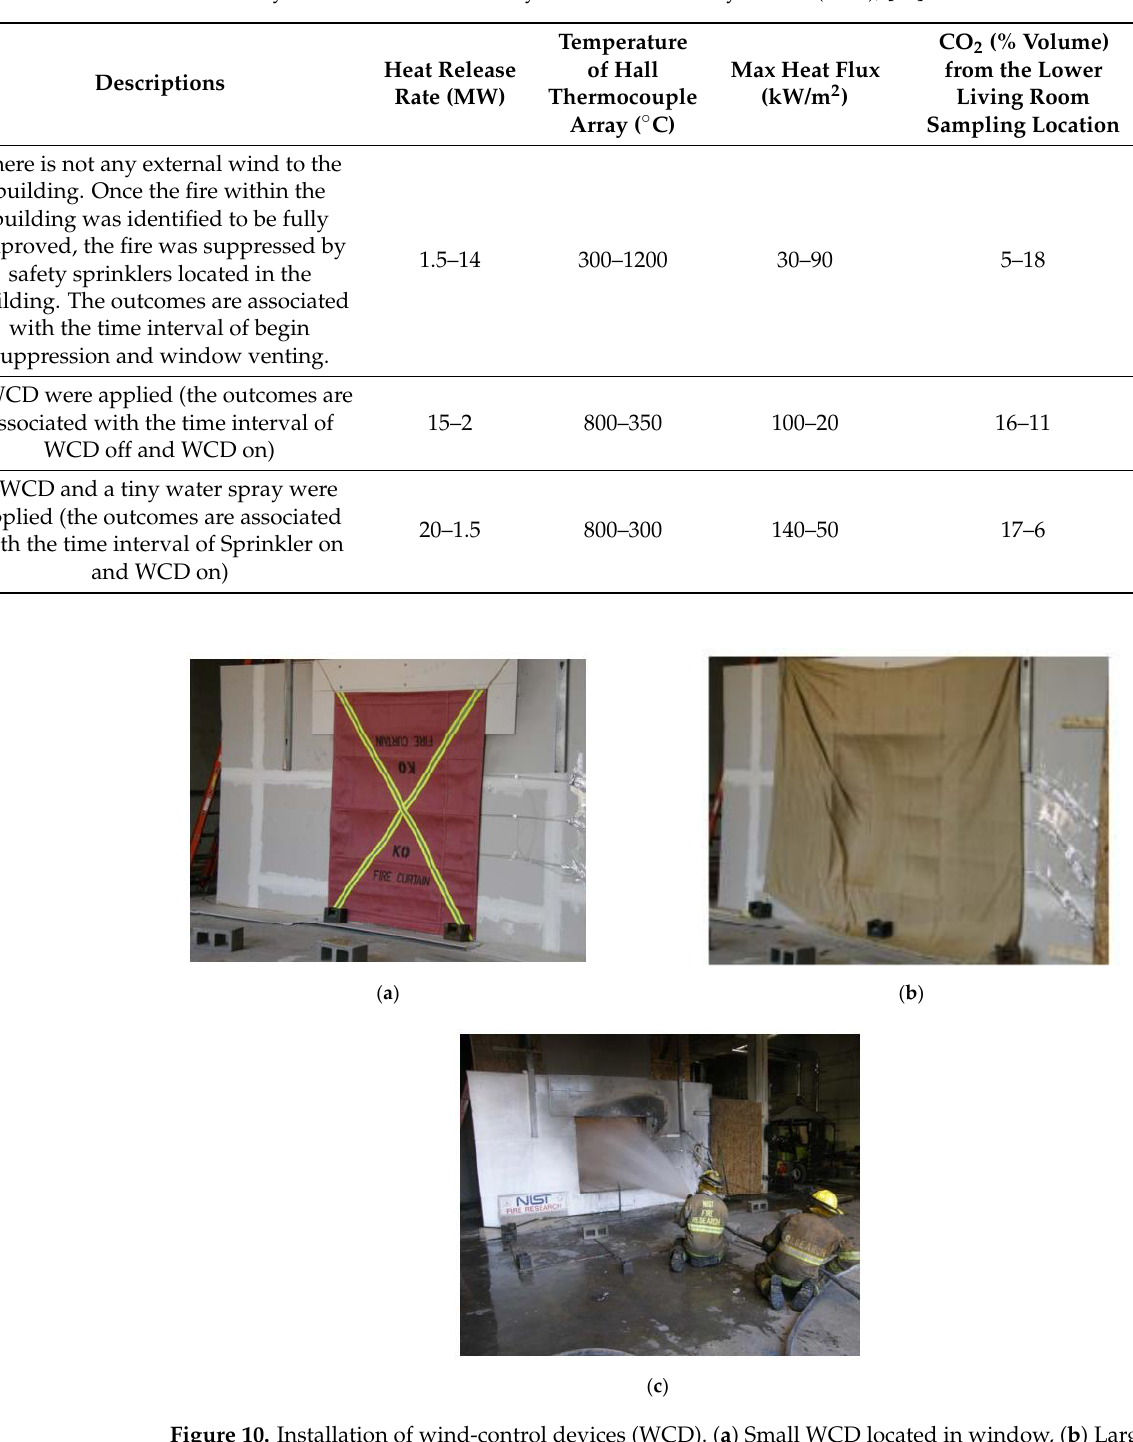
Table 1. The summary of the tests conducted by Kerber and Madrzykowski (2009), [86]. Exp.